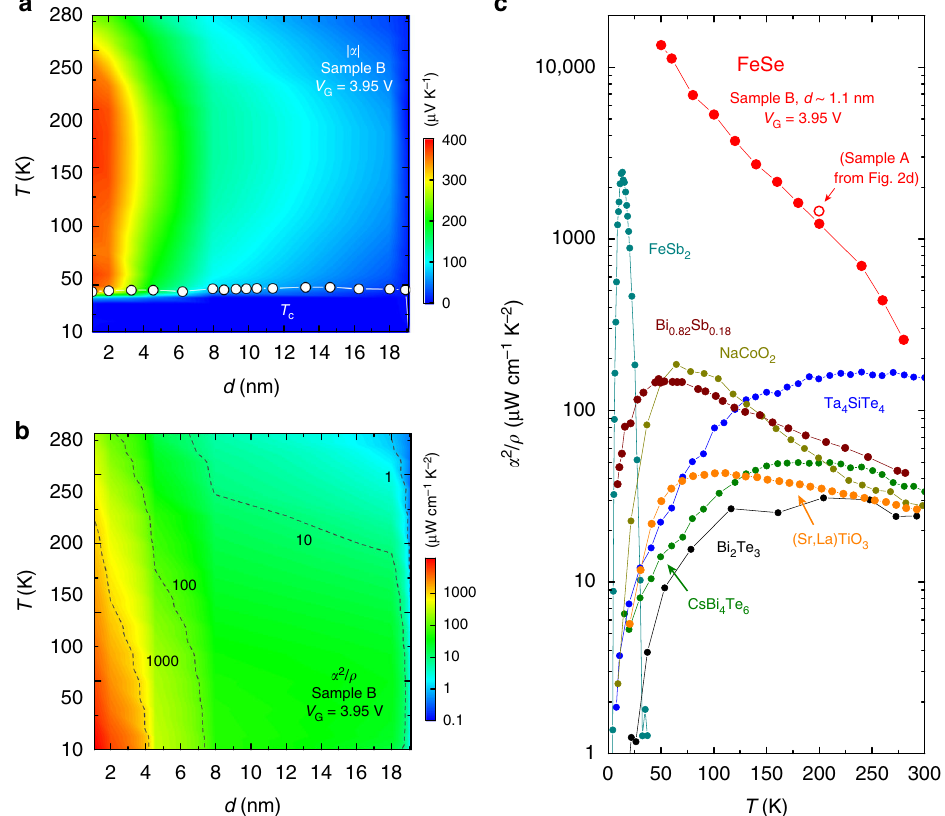
Fig. 3 Giant thermoelectric response in ultrathin FeSe. a Mapping of Seebeck coef fi cient α of FeSe (Sample B) against temperature T and thickness d . Here, the absolute value of α (i.g., | α |) for V G = 3.95 V was plotted. The white circles correspond to the onset temperature T c of the superconducting transition. b Evolution of thermoelectric power factor α 2 / ρ of FeSe (Sample B) above T c . The value of α 2 / ρ increased with decreasing d , mainly owing to the large enhancement of α shown in a . c Comparison of temperature dependence of α 2 / ρ among representative thermoelectric materials. The values of α 2 / ρ in the FeSe ultrathin fi lm were larger than any existing bulk materials reported so far in a wide temperature range (see Supplementary Table 1 for the reference of the experimental values). The data point for Sample A at 200 K (open circle) shows fair